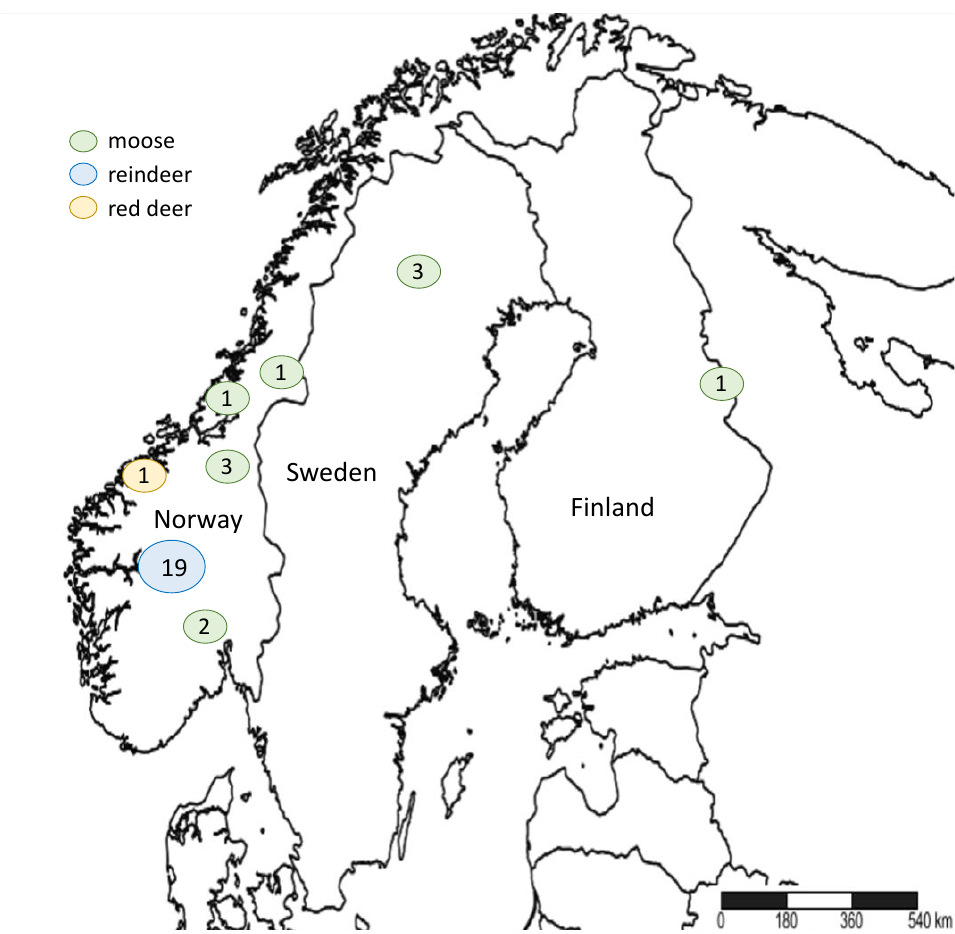
Figure 2. Chronic wasting disease (CWD) distribution in Scandinavia, based on Mysterud et al., 2020 [35]. Numbers in circles represent the number of CWD-positive animals.